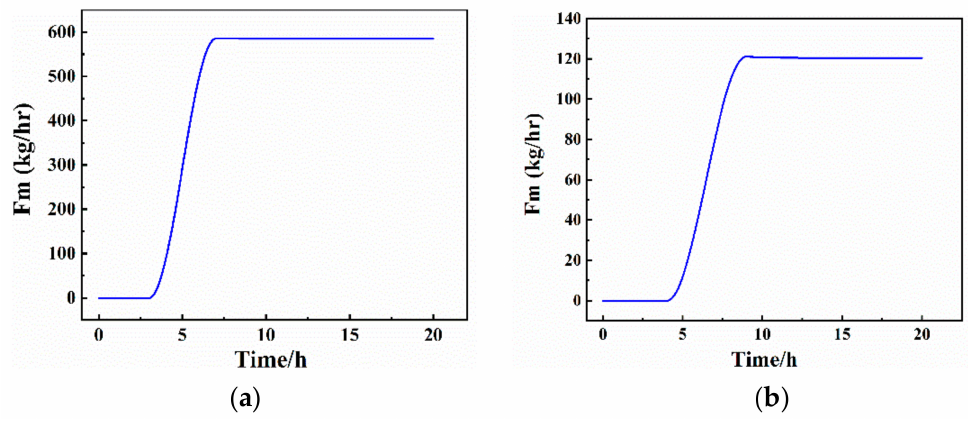
Figure 5. Total mass flow changes of S15 ( a ) and S34 ( b